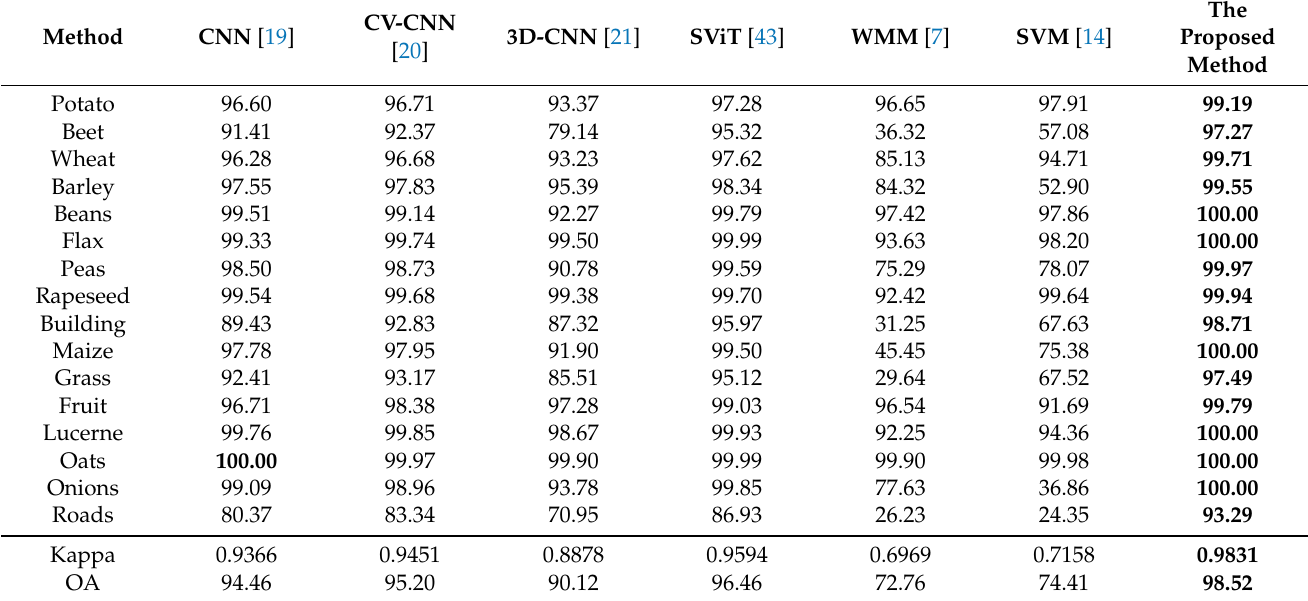
Table 3. Classification results on the L-band Flevoland dataset.